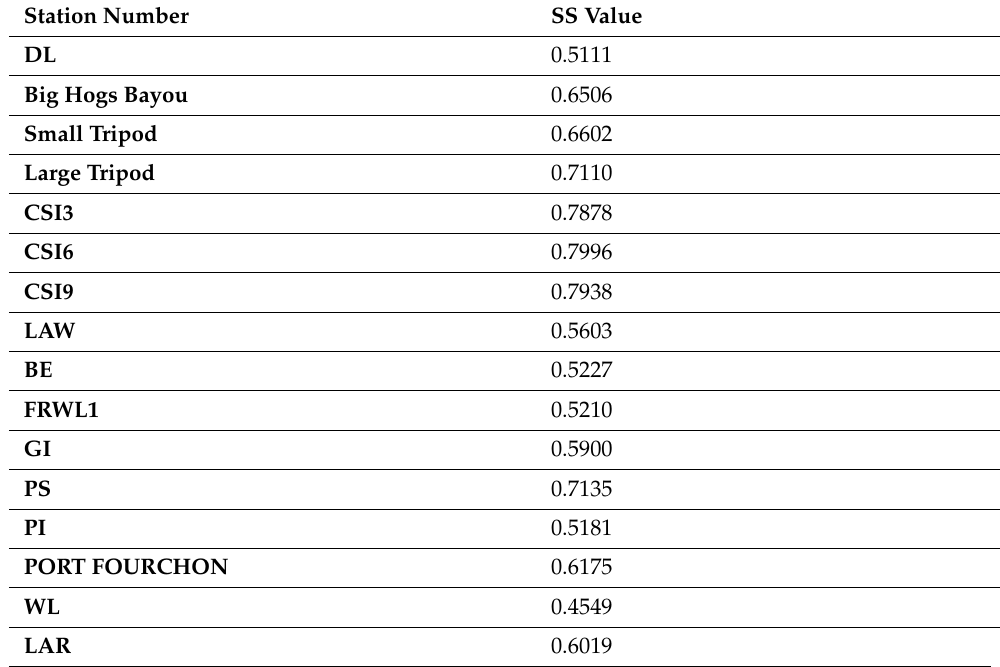
Table 2. Skill score (SS) value of water level for 14